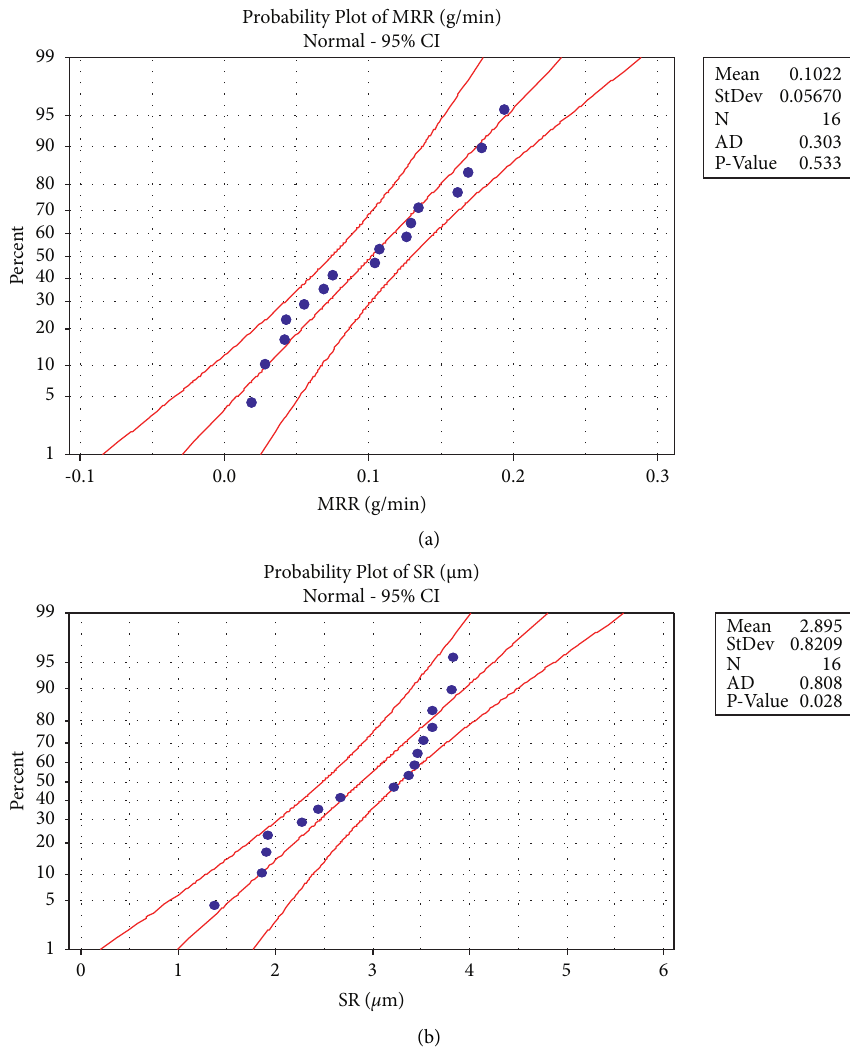
Figure 6: (a) Probability plot for MRR. (b) Probability plot for SR.